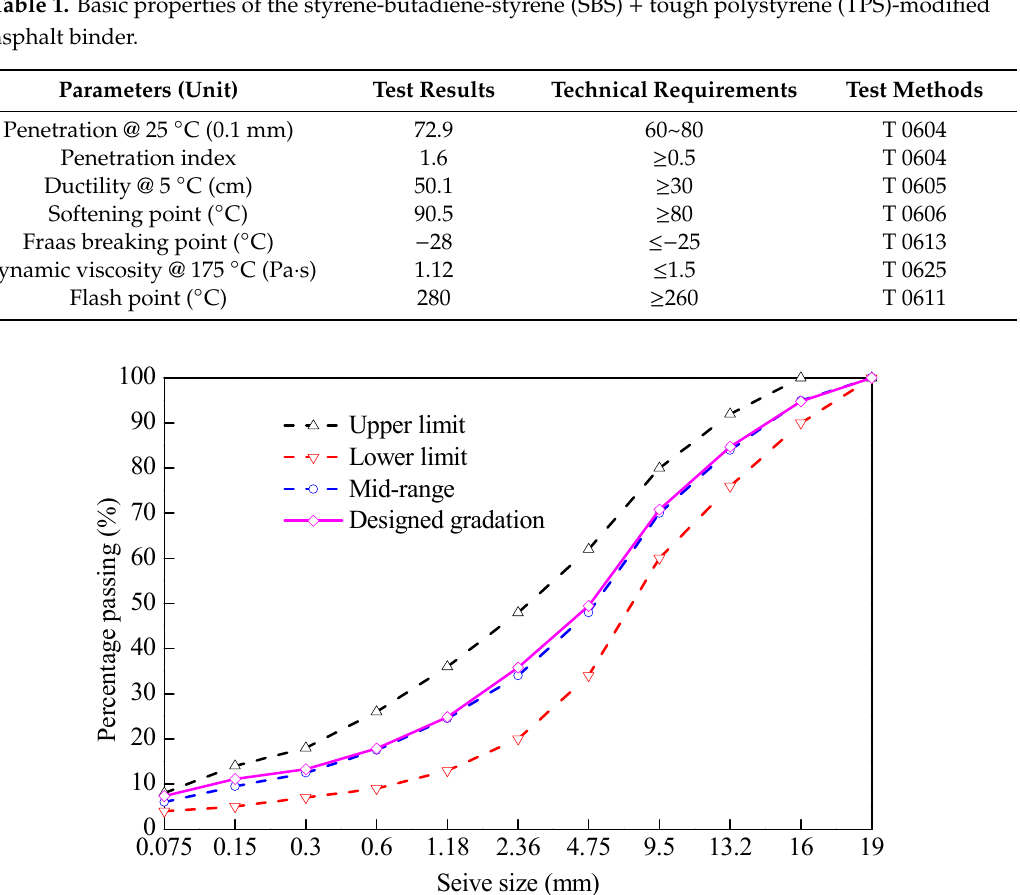
Table 1. Basic properties of the styrene-butadiene-styrene (SBS) + tough polystyrene (TPS)-modified asphalt binder.